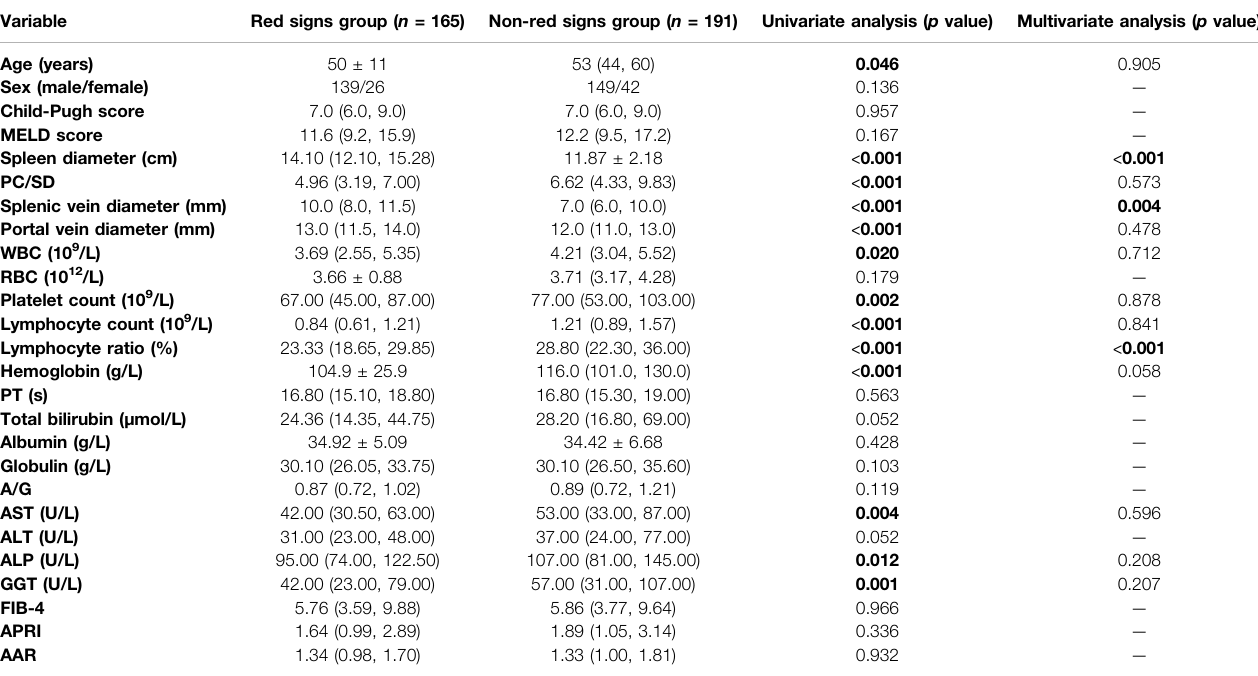
TABLE 4 | Univariate and multivariate analysis of variables according to the presence of red signs.